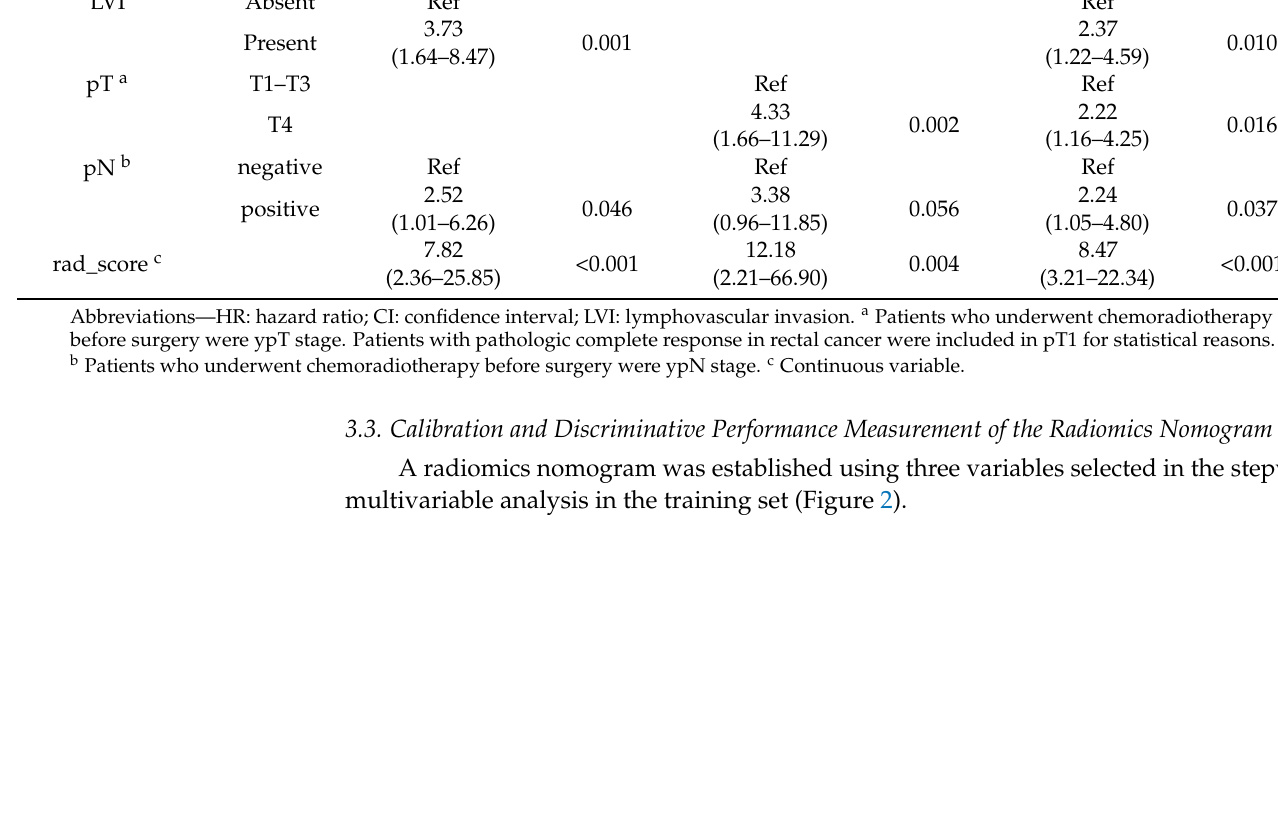
Table 4. Multivariable analysis associated with progression-free survival in the training set, validation set, and overall set.